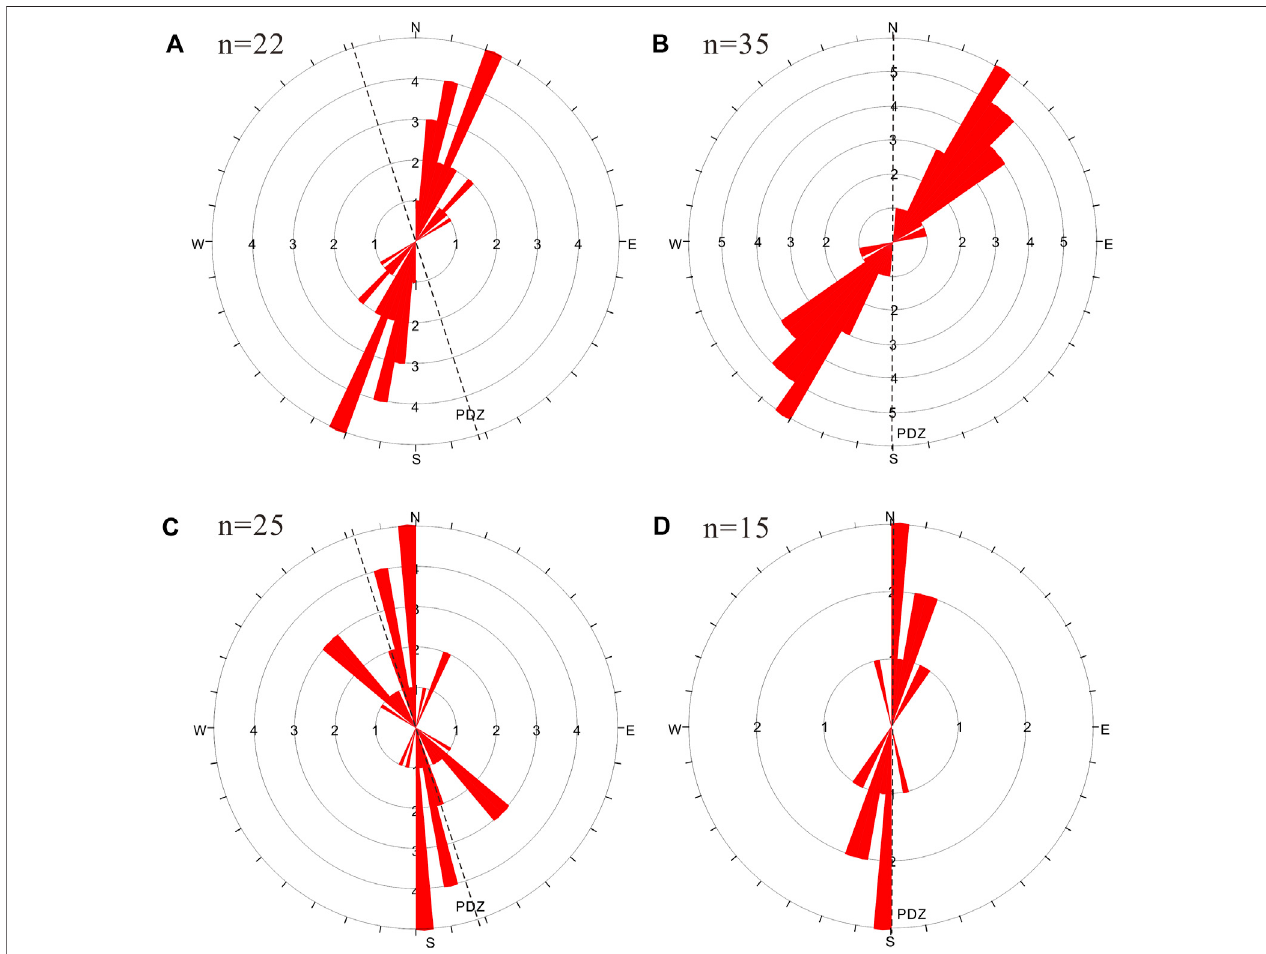
FIGURE6| Strike-weightedrosediagramsforeachfault setinthebottomoftheSilurian(T 70 )andthebottomoftheUpperOrdovician(T 74 ). (A) Thenorthsegment of SB5 in T 70 ; (B) The south segment of SB5 in T 70 ; (C) The north segment of SB5 in T 74 ; (D) The south segment of SB5 in T 74 . PDZ (cid:2) principal displacement zone. The boundary between the northern and southern segments of SB5 is the turning pint of SB5 in Figure 5B .